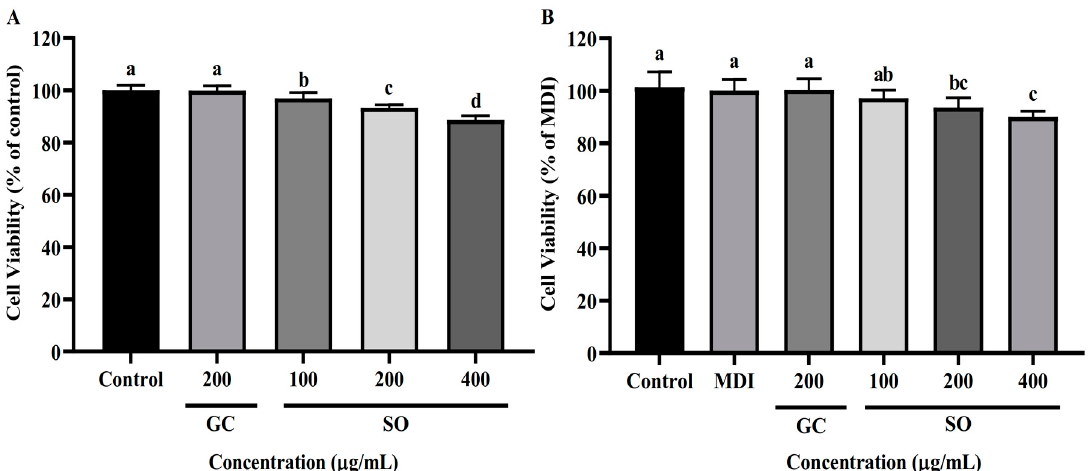
(Figure 2B). The viability of cells treated with all concentrations of SO (100–400 µ g/mL) was above 80%, indicating no apparent toxicity to the cells [30].